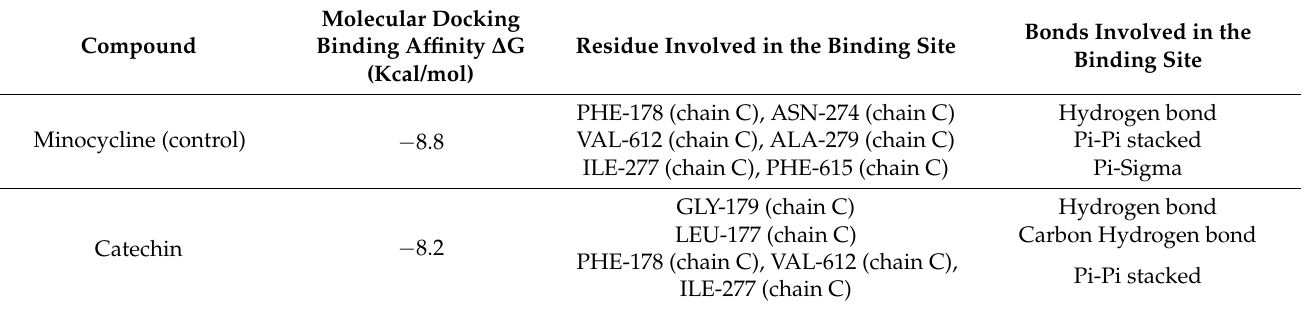
Table 3. Binding affinity of catechin to AcrB protein of E. coli.